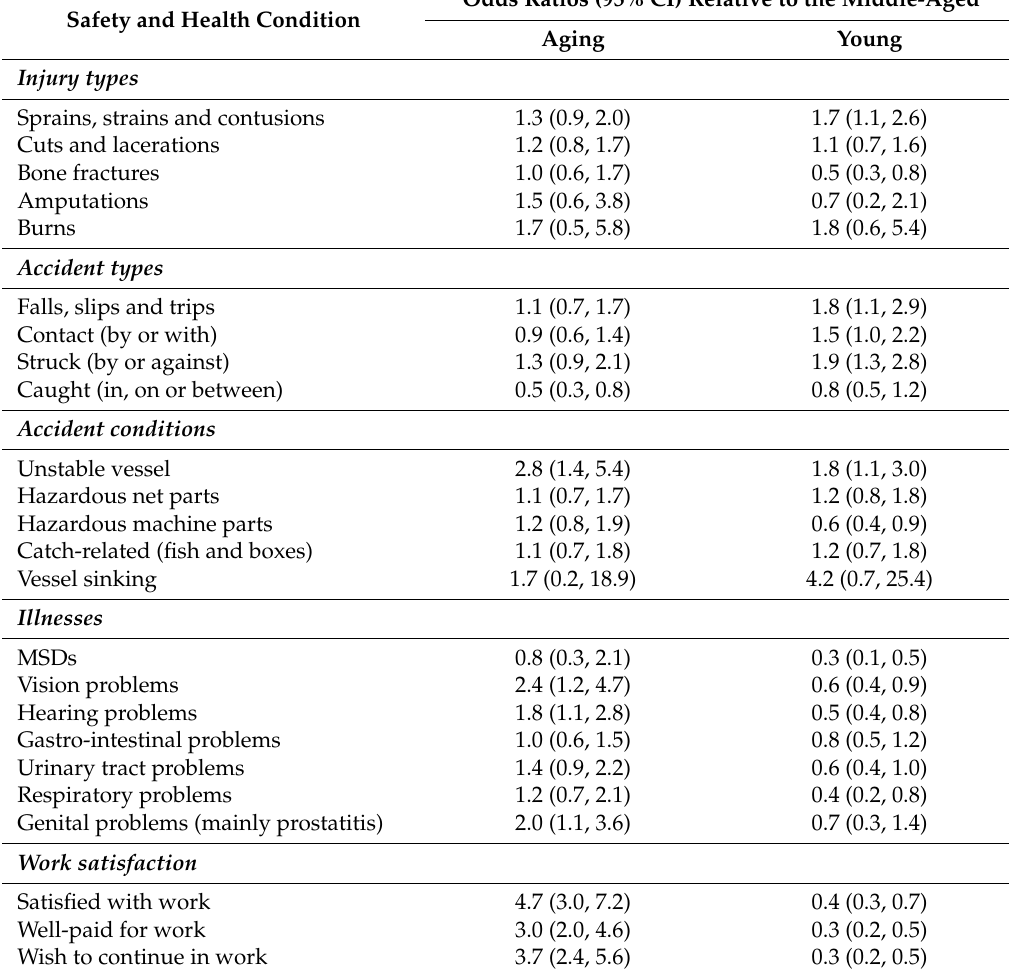
Table 2. Logistic regression analysis of the association of age groups (as predictor) with accident conditions, accident types, injury types and self-reported illnesses (as